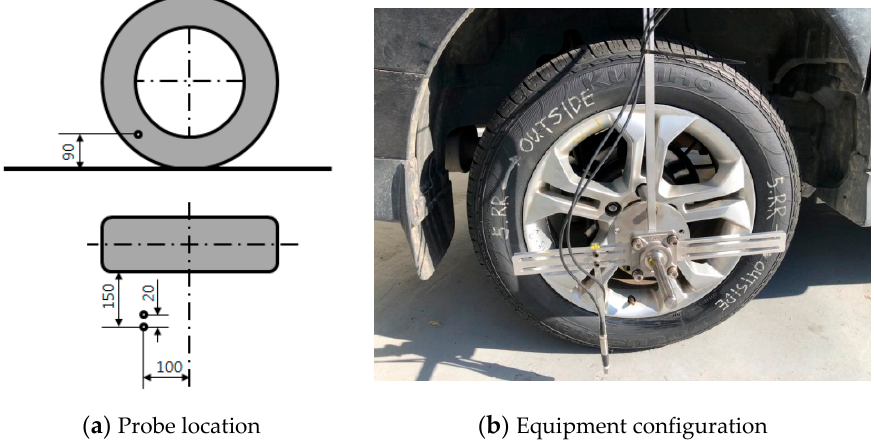
Figure 2. Probe location and equipment configuration of the A-CPX method.